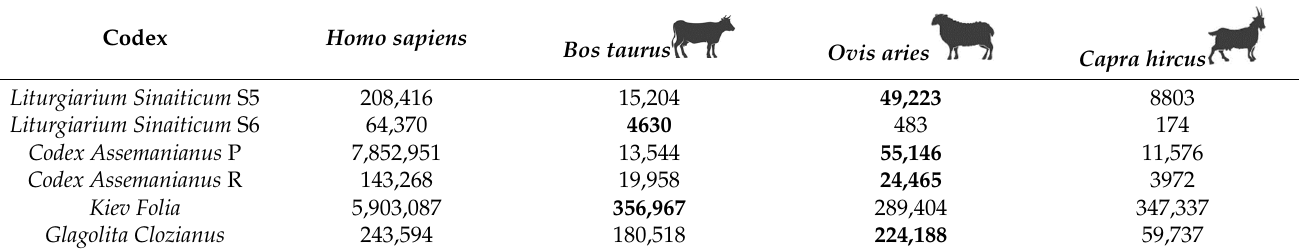
Table 1. Animal species identified in investigated ancient Slavonic codices showing the total numbers of reads affiliating with each animal species. The data concerning the Liturgiarium Sinaiticum and the Codex Assemanianus are published in Piñar et al. 2020 [3], the data from the Kiev folia in Cappa et al. [8] and the data from the Glagolita Clozianus are shown here for the first time. The whole methodological and data analysis procedure that was applied to the latter codex was done in exactly the same way as it was for the Kiev Folia [8] (for more details see supplementary Material File S1 and Figure S1). Bold marked: indicate the highest number of reads related to a specific animal besides humans in each sample.